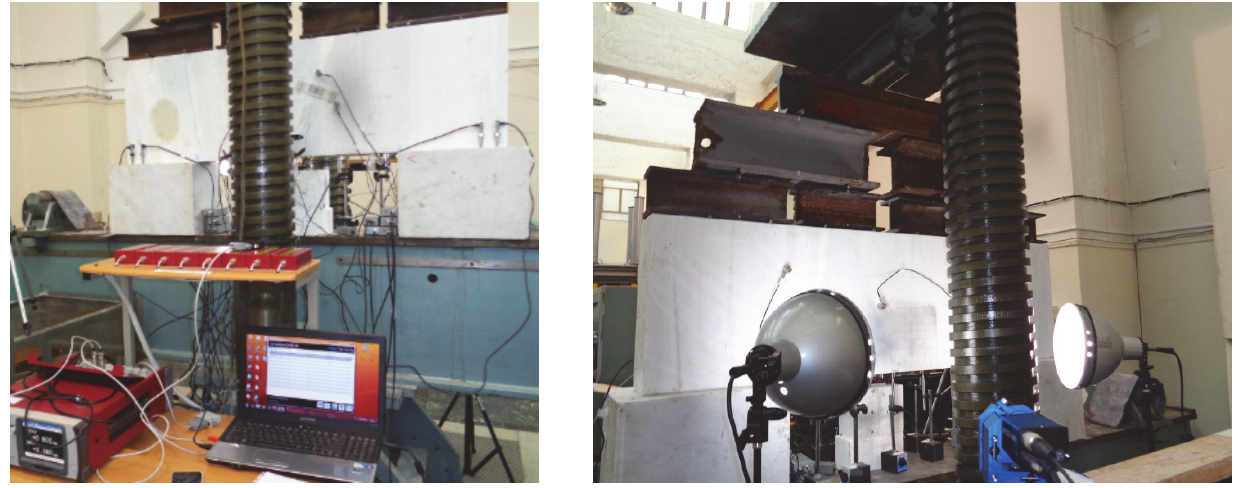
Figure 2: An overview of the experimental